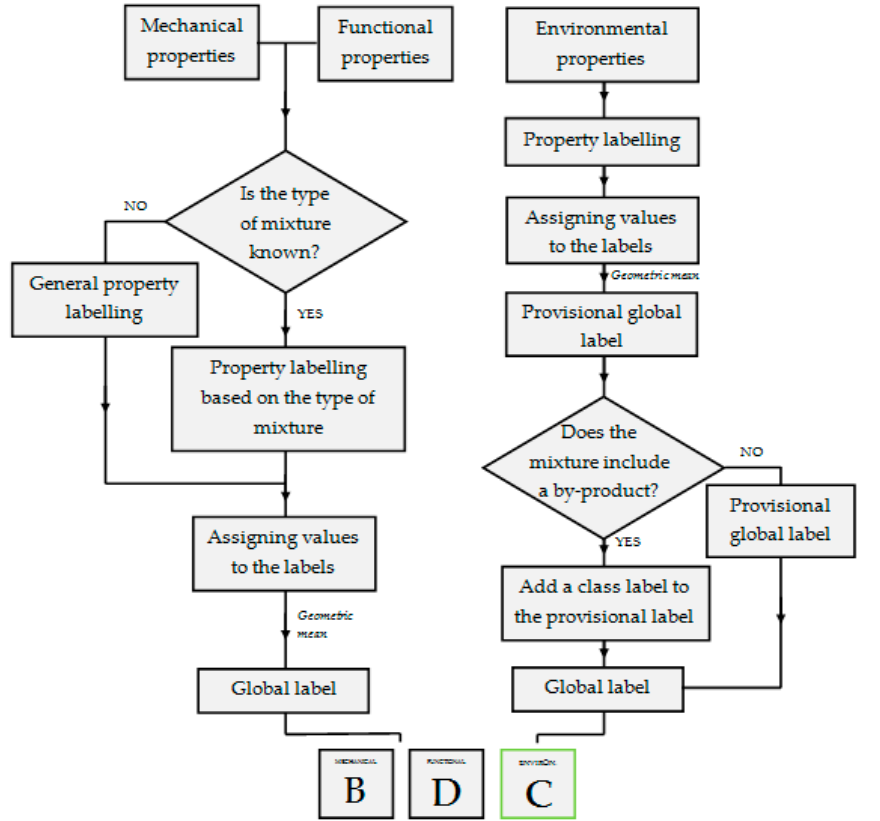
Figure 9. Flowchart of the global labeling scheme.